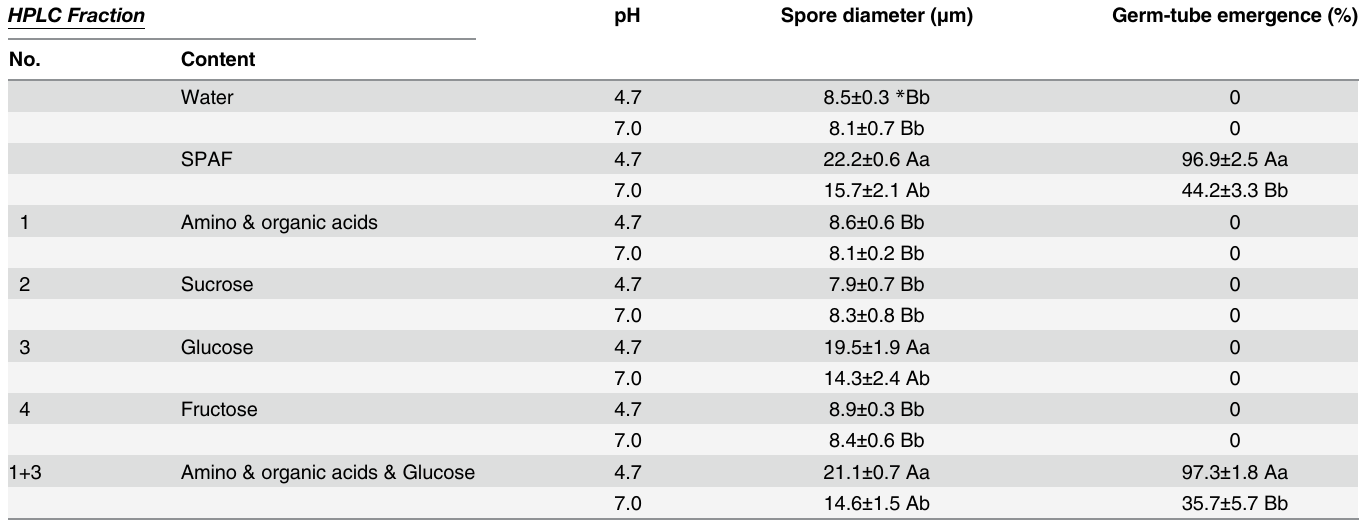
* Within each pH level (4.7 or 7.0) different upper case letters are signi fi cantly different from each other (P (cid:2) 0.05). Within each pair of pH level in the same fraction content (Water, SPAF, etc.), lowercase letters are signi fi cantly different from each other (P (cid:2) 0.05).